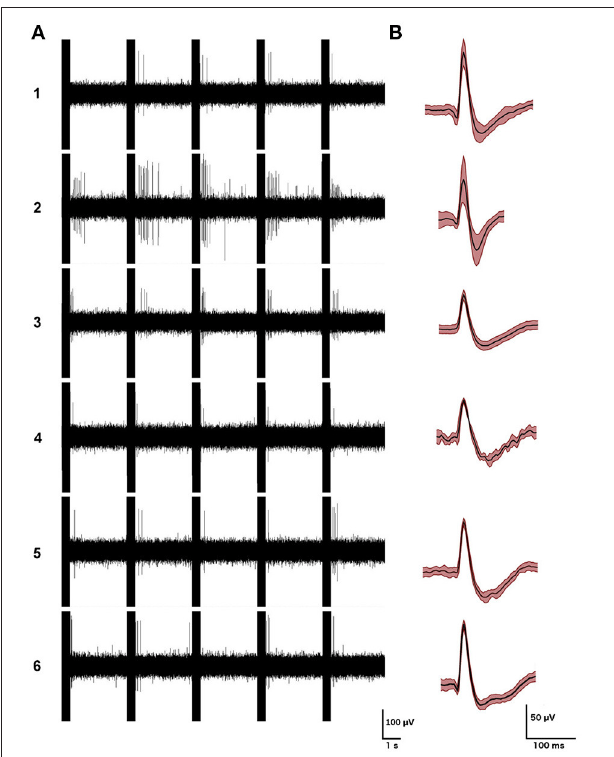
FIGURE 3 | Examples of the firing patterns of the 6 single striatal neurons responding to electrical stimulation of the vestibular labyrinth in a phase-locked manner, (A) with examples of their action potential waveforms (averages of 200 action potentials (B) ; mean ± SD in red). From Stiles et al. ( 59) with permission.